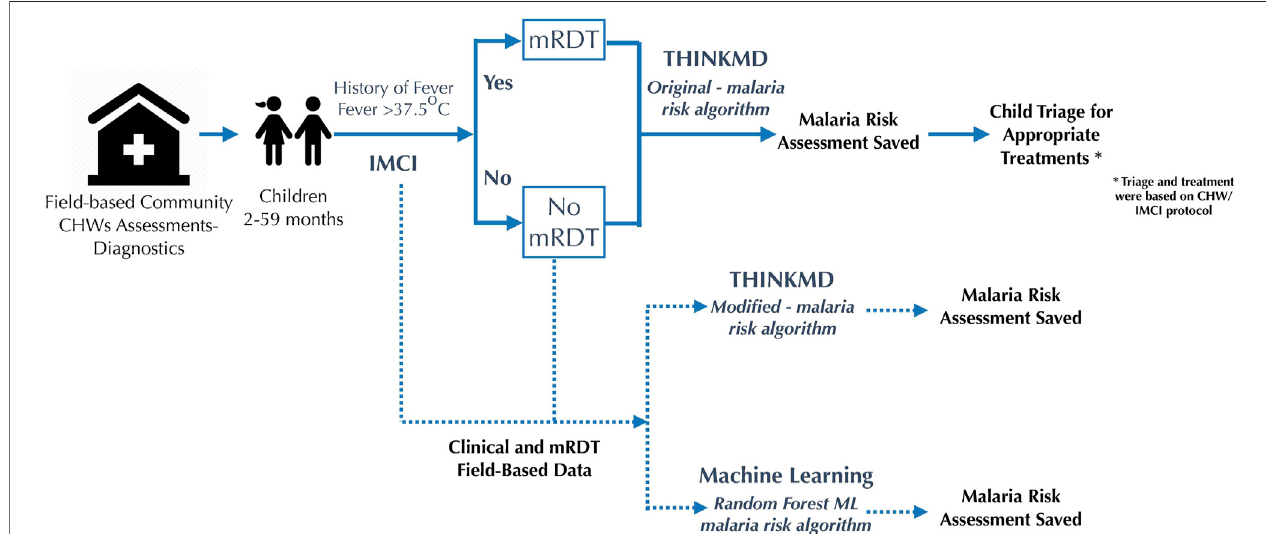
FIGURE 1 | Patient fl